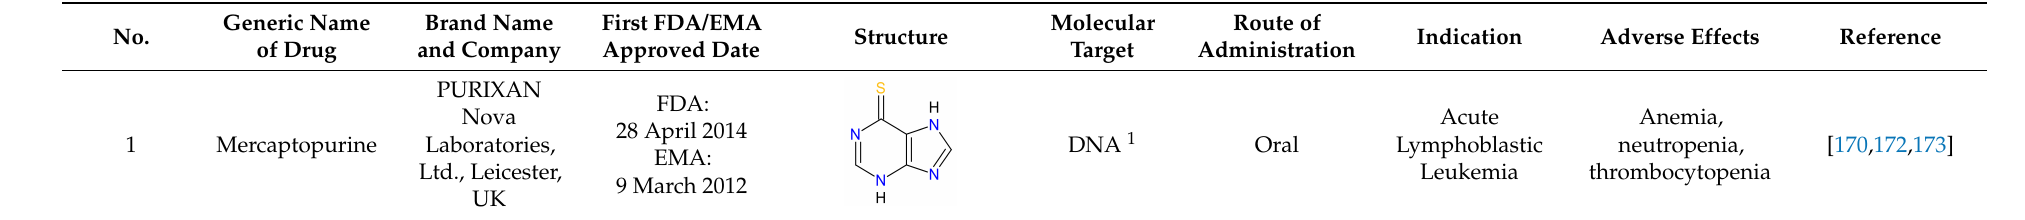
Table 8. Features of the purine antagonist approved by the Food and Drug Administration (FDA) from 2011 to